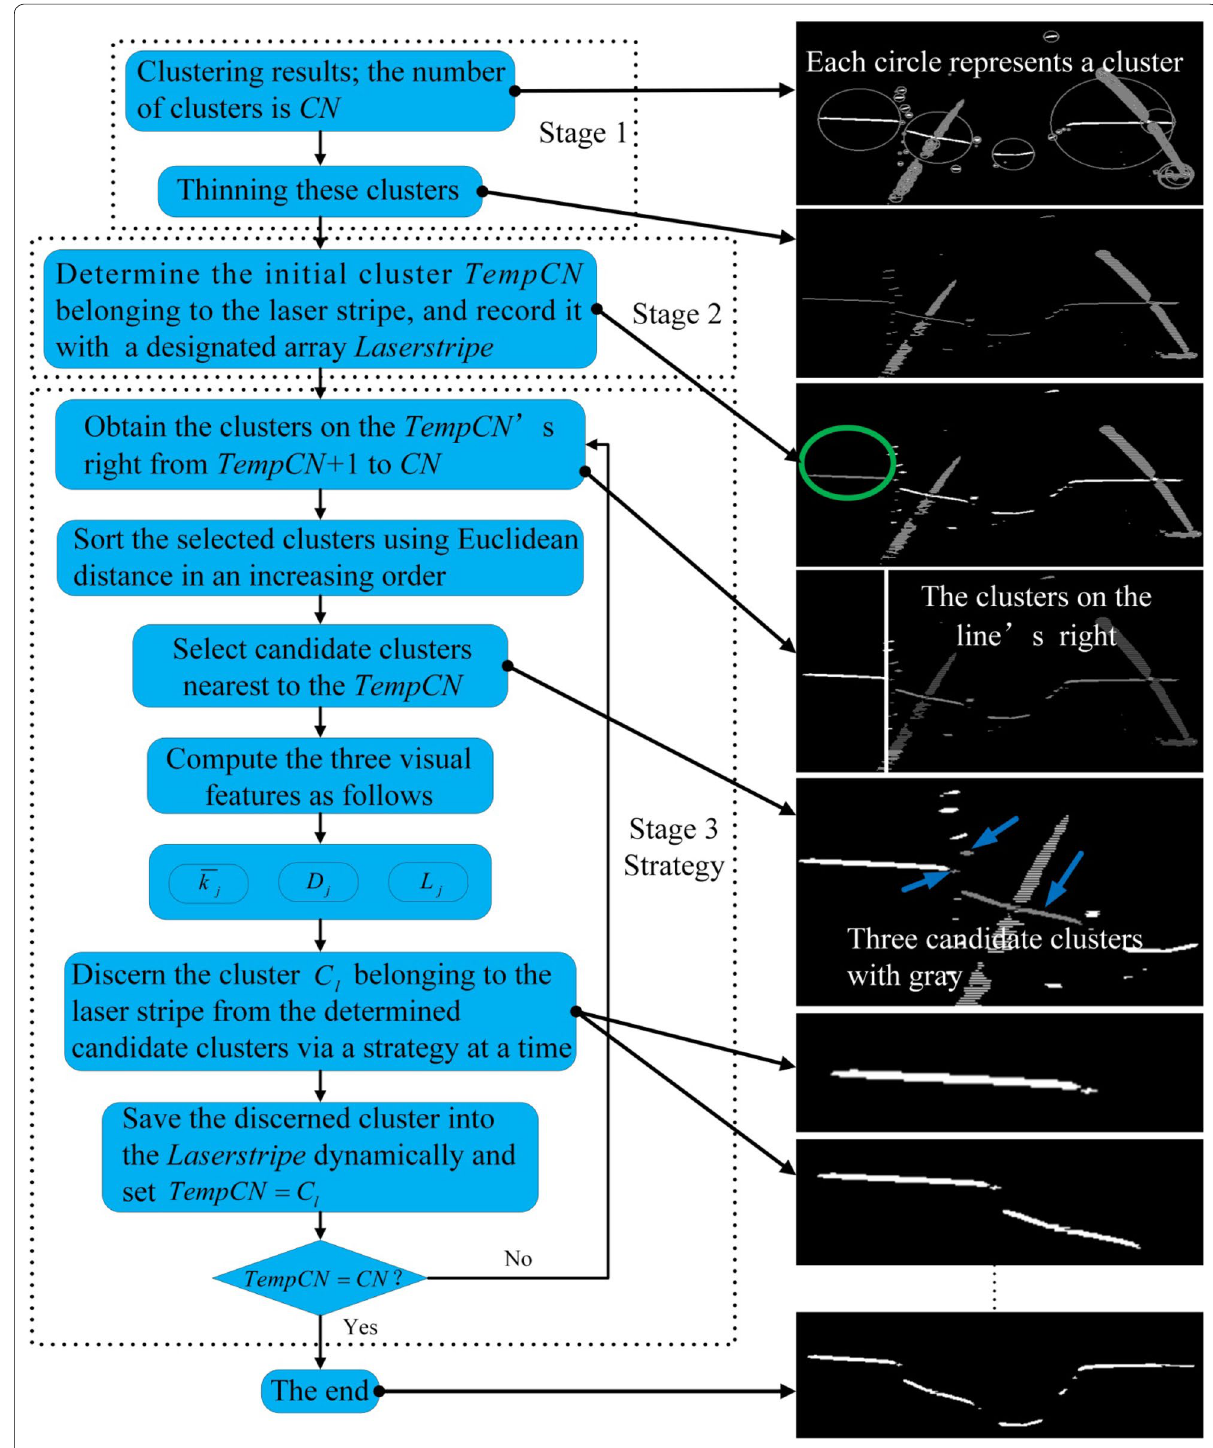
Figure 7 Scheme of discerning clusters that belong to the WSP from interference